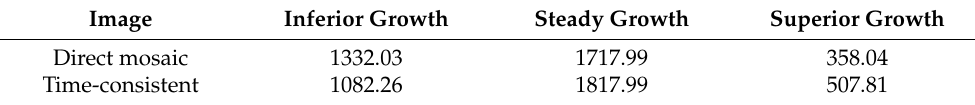
Table 8. Grassland growth area statistics based on different image synthesis methods (km 2 ).